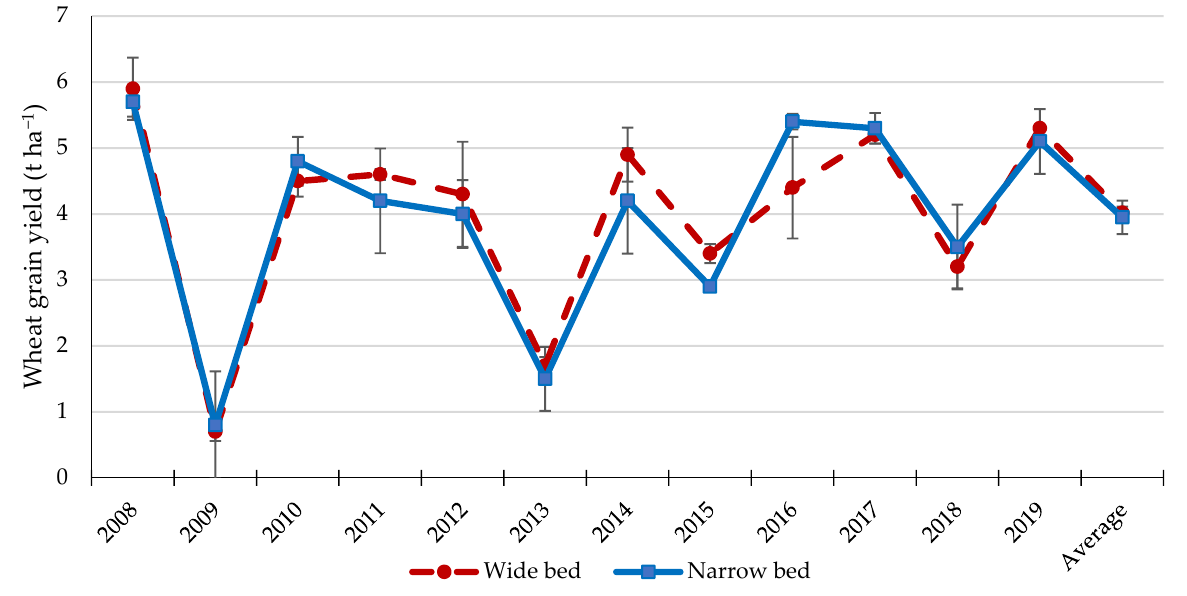
Figure 6. Average wheat yield in wide and narrow beds in Texcoco II. Average yield for each year during the duration of the study; the error bars represent the standard deviation of the mean.